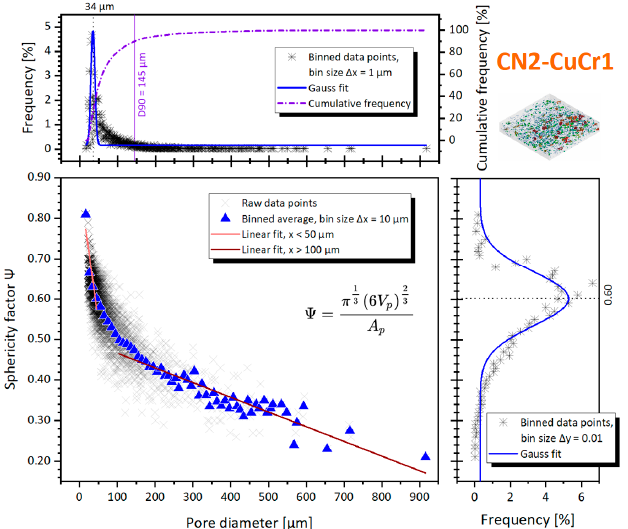
Figure 13. Pore diameter against the sphericity factor for the CN2-CuCr1 sample; inserts with per- centage frequency distributions of both sphericity and diameter are included.